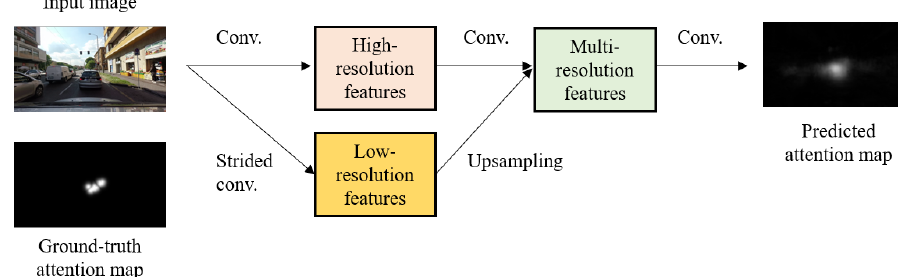
Figure 1. Where is a salient location required by a driver? Given images, this work aims to predict a driver’s attention location. The proposed framework transforms input images into their spatially corresponding attention maps. The output attention map where the map value at every pixel location directly represents a driver’s visual attention, abstracts from fused features of multiple